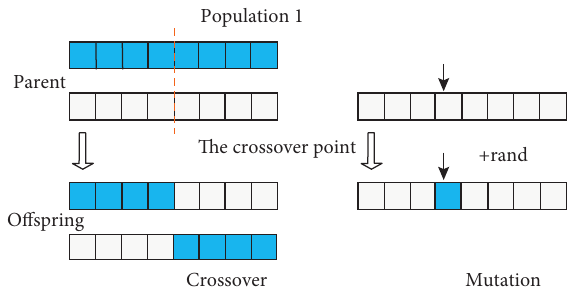
Figure 5: Crossover and mutation operation in real-valued